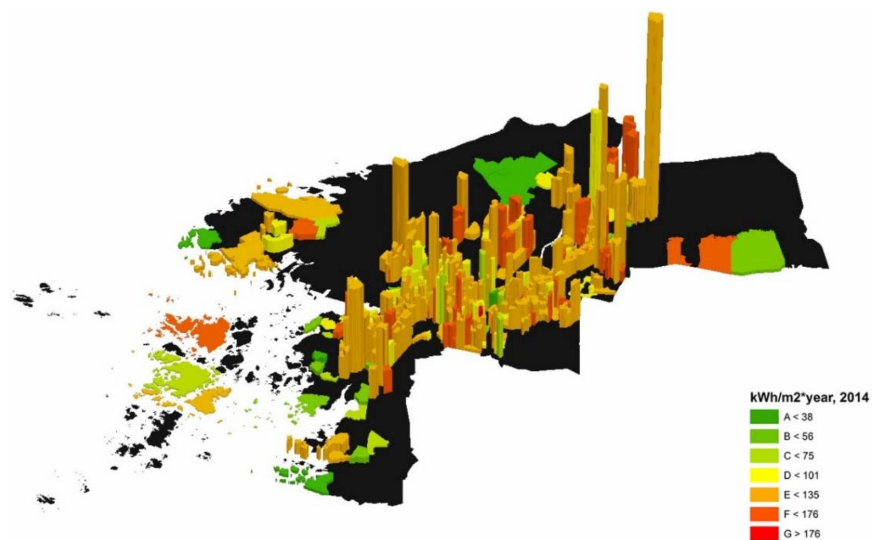
Figure 6. 3D visualization of energy performance and total energy use in aggregated–base areas. The color of the bar represents the average energy performance using the scale from the EPC [kWh/m 2 ] while the height represents the total energy use of buildings in the different statistical areas [GWh].